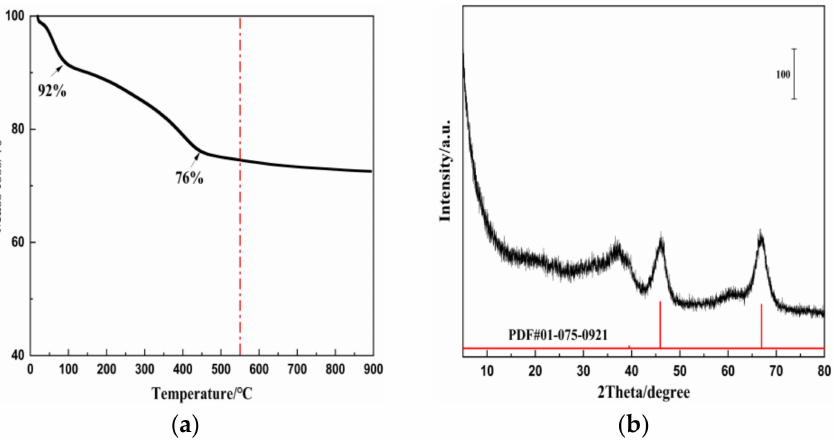
Figure 1. TG curve of pseudo-boehmite ( a ); XRD pattern of pseudo-boehmite sample after calcination ( b